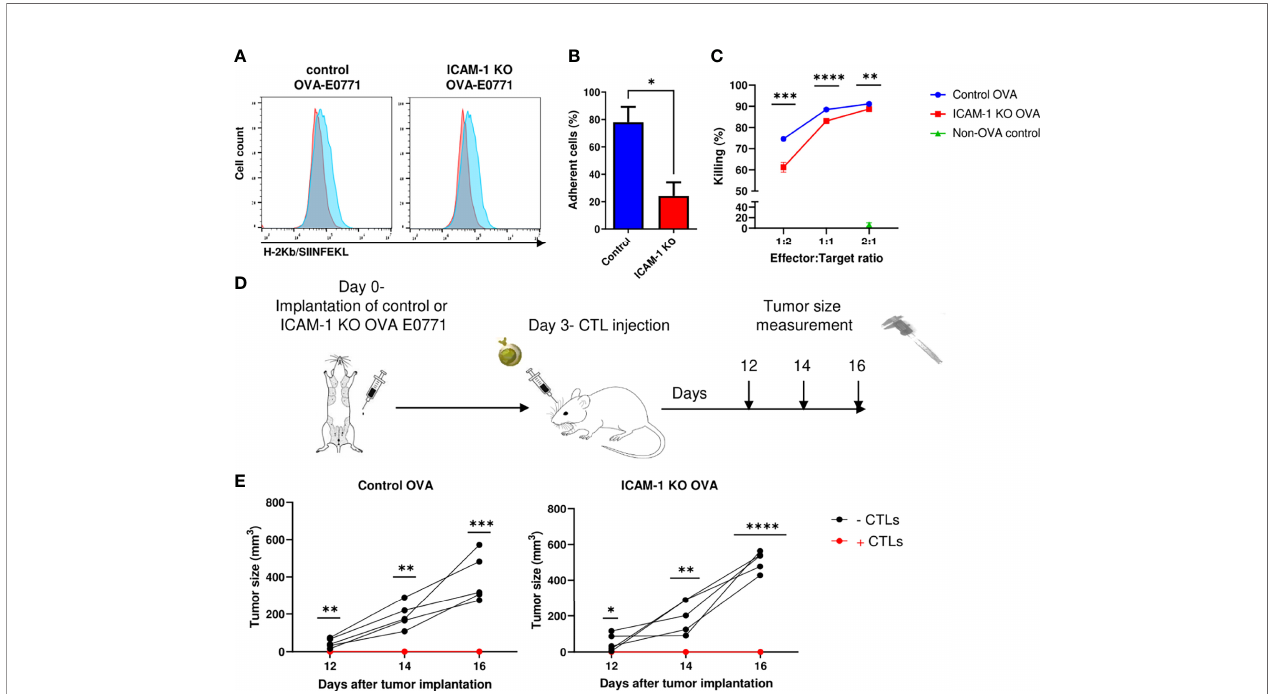
FIGURE 3 | Killing of OVA-expressing breast cancer E0771 cells in vivo by ex vivo expanded OT-1 CTLs is ICAM-1 independent. (A) Expression of the OVA-derived SIINFEKL peptide complexed with H-2Kb on control and ICAM-1 KO E0771 cells infected with an OVA-mCherry encoding vector. The SIINFEKL/H-2Kb expression was detected with the 25-D1.16 mAb (32) and a secondary Ab (Blue). Staining with the control secondary Ab is shown in red. (B) ICAM-1 on E0771 cells is functionally adhesive. OT-1 effector CTLs were settled on the monolayers of control or ICAM-1 KO E0771 cells for 4 min and subsequently subjected to progressively increasing shear stresses as described in the Materials and Methods section. The fractions of CTLs that remained adherent to the monolayers at the highest shear stress were determined in three fi elds of view. * p <0.05. (C) The killing of control or ICAM-1 KO OVA- expressing E0771 cells or non-OVA expressing control E0771 cells by OT-I effector CTLs was tested in vitro . Tumor cells were seeded in triplicate in 96- well plates, and 24 h later, CTLs were added to the wells in different effectors to E0771 target ratios. The number of viable OVA-expressing tumor cells in the wells was counted 24 h later, and the percentage of killing was calculated as explained in the Materials and Methods section. n=4. ** p <0.005; *** p <0.0005. **** p <0.0001 for control and ICAM-1 KO OVA E0771 groups. (D) A scheme depicting the experiment. Mice were implanted with control or ICAM-1 KO OVA expressing E0771 cells as in Figure 1C . Approximately 3 days later, 10 7 of the OT-I effector CTLs were injected i.v. to each of the indicated experimental groups. (E) The tumor size was measured on days 12, 14, and 16 postimplantation. n=5. * p <0.05; ** p <0.005; *** p <0.0005; **** p